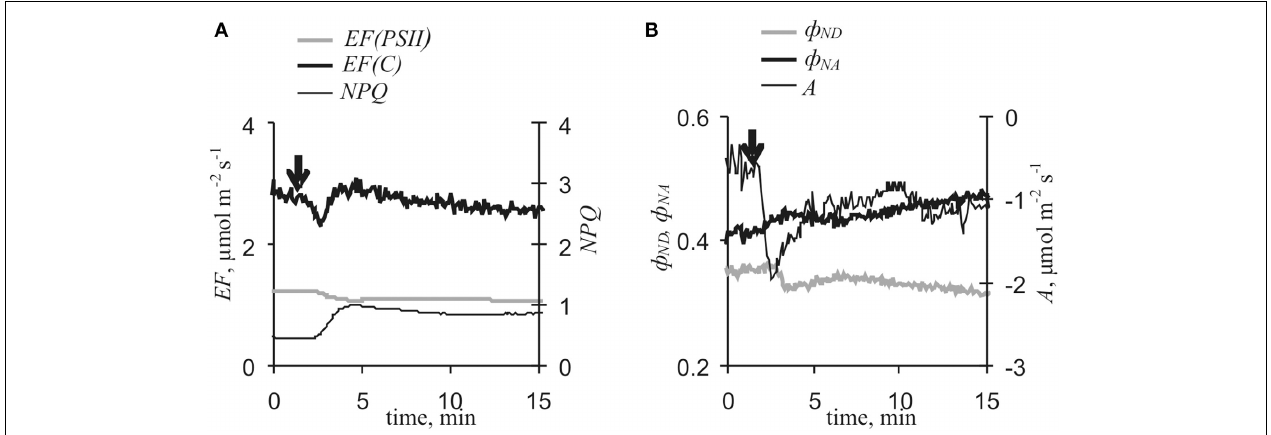
FIGURE 7 | Variation potential-induced changes in photosynthetic light stage parameters and CO 2 assimilation under far red light conditions ( n = 9). (A) EF(PSII) , EF(C) and NPQ . (B) φ ND , φ NA , and A . Arrow, VP induction by local heating.